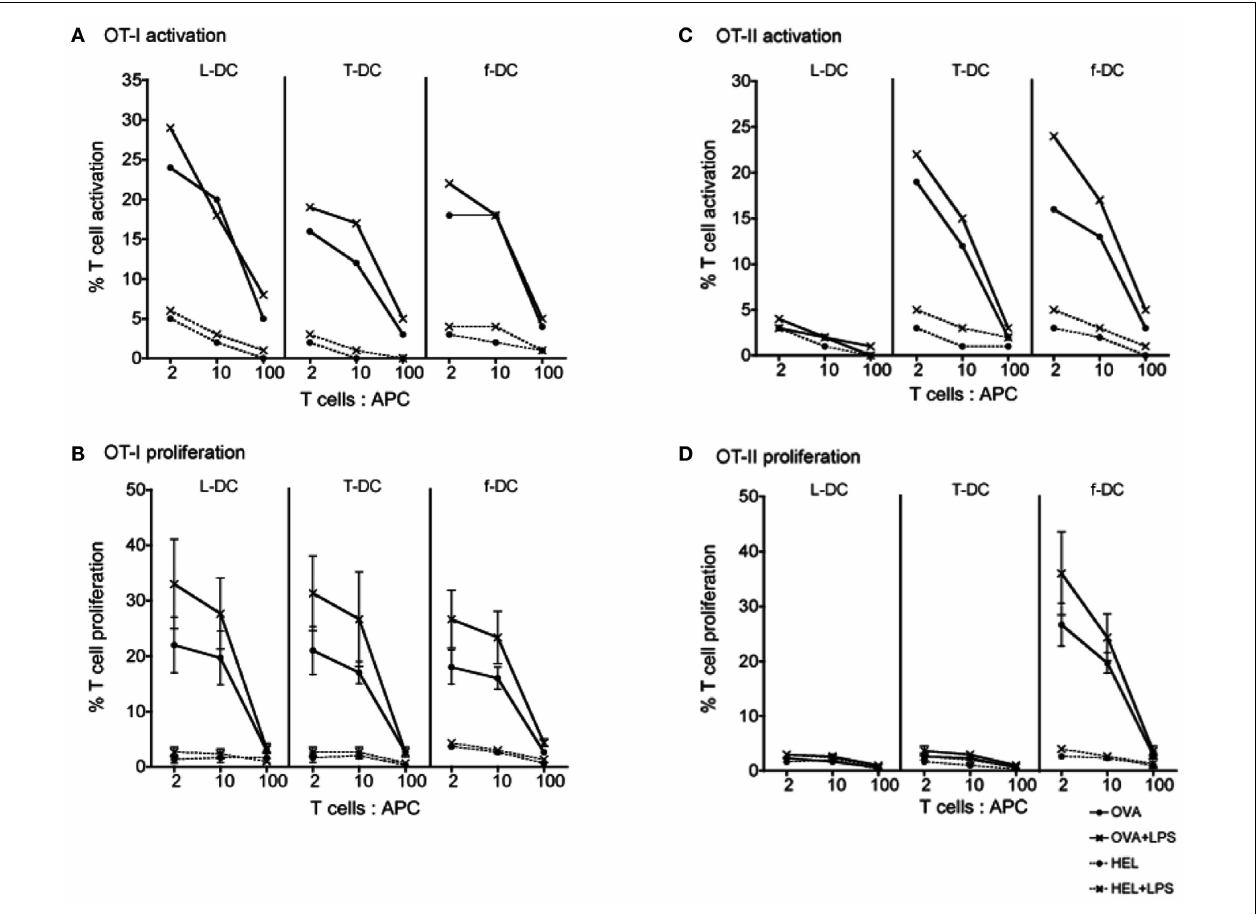
cell: APC ratios and with CFSE-labeled CD8 + or CD4 + T cells purified from OT-I or OT-II spleens through depletion of B cells, myeloid cells, DC, and CD4 + or CD8 + T cells. (A,C) T cell activation was analyzed after 24h in terms of % cells staining for CD69 in one of three replicate experiments. (B,D) T cell proliferation was measured after 4days in terms of % cells showing a reduction in CFSE staining.T cells were gated as live (PI − ) CD11c − Thy1.2 + V α 2 + cells which were CD4 + or CD8 + using flow cytometry. Data represent mean ± SE of three replicate experiments.T cell only control (not shown) was <